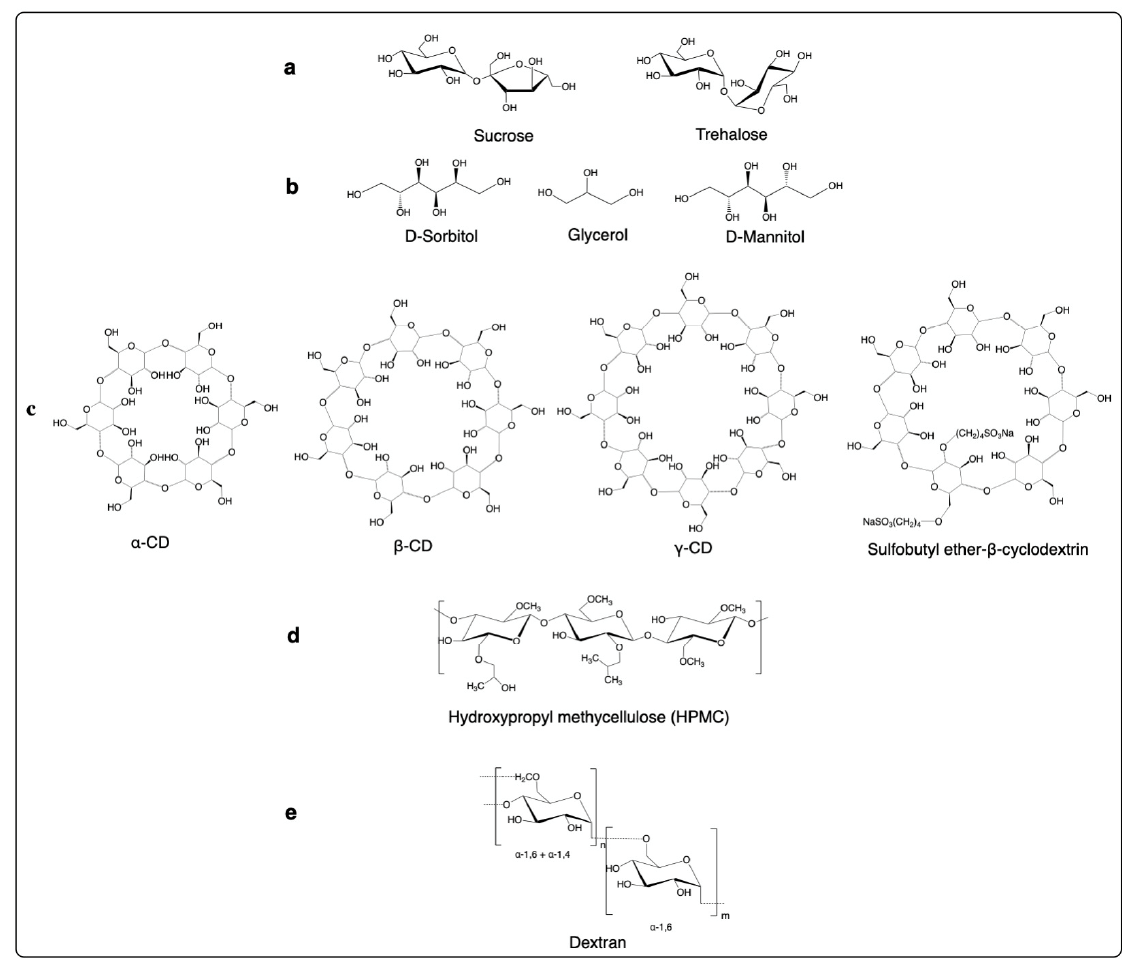
Figure 3. Chemical structures of potential carbohydrate PS alternatives: ( a ) Disaccharides, ( b ) Sugar alcohols, ( c ) Cyclodextrins (CD), ( d ) Hydroxypropyl methylcellulose, and ( e ) Dextran.